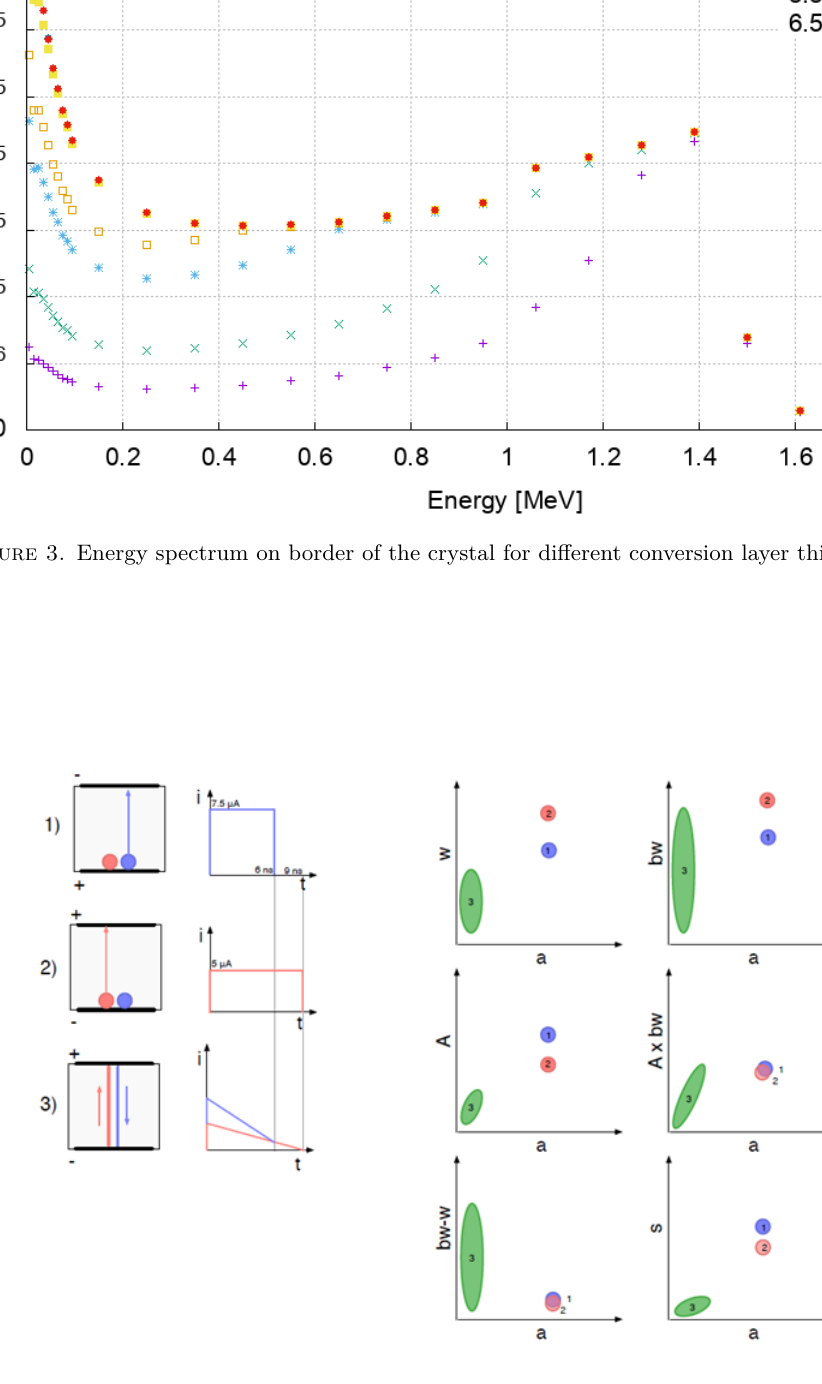
Figure 4. Theoretical interaction of 1) and 2) alpha particles; 3) gamma or electrons [11] (a - area, A - amplitude, w - width, bw - base